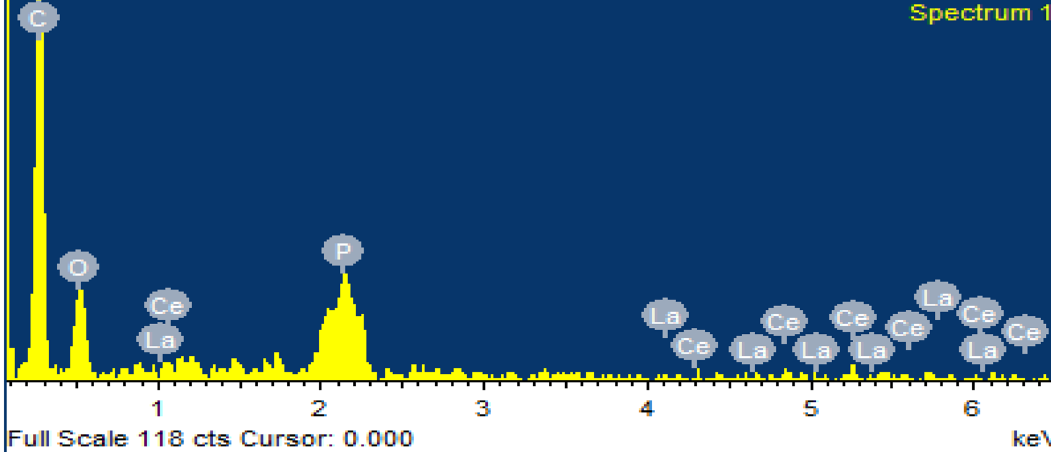
Figure 4. EDX image of SIR after Ce(ΙΙΙ) and La(ΙΙΙ) ions